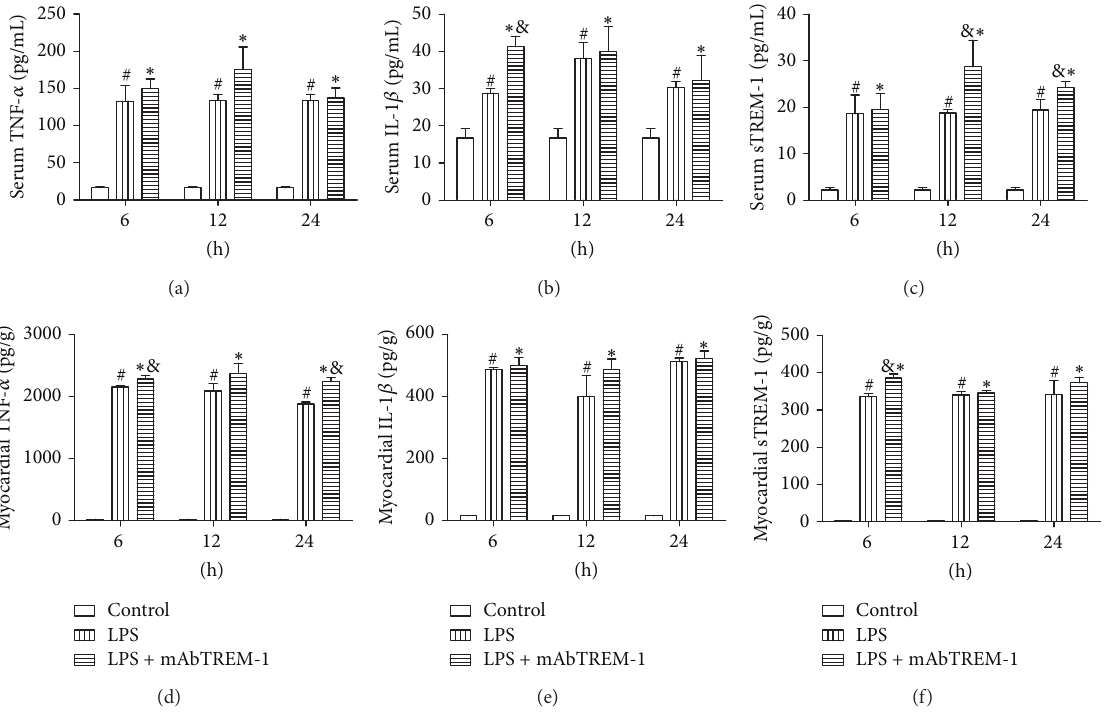
Figure 2: Serum TNF- 𝛼 (a), IL-1 𝛽 (b), sTREM-1 (c) and myocardium TNF- 𝛼 (d), IL-1 𝛽 (e), and sTREM-1 (f) levels at 6h, 12 h, and 24 h among three groups as described in Materials and Methods; data are expressed as MEAN ± SEM; # 𝑃 < 0.05 compared with saline-treated mice, ∗ 𝑃 < 0.05 compared with saline-treated mice, and & 𝑃 < 0.05 compared with LPS-treated mice.